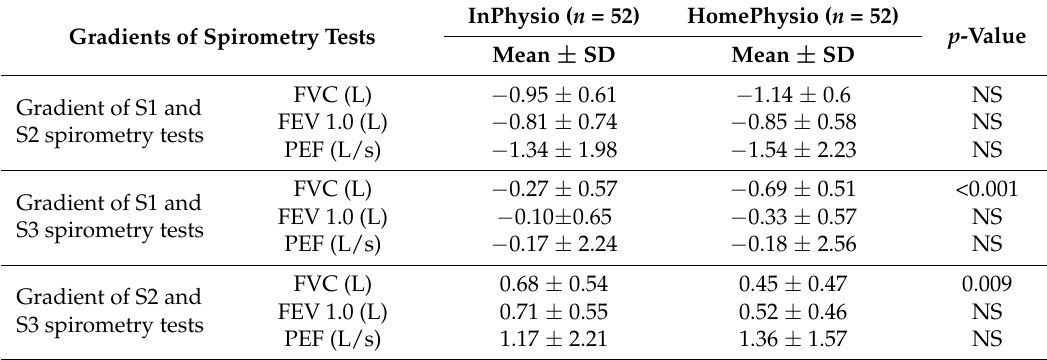
Table 3. The intra-group assessment. Evaluation of average gradients of spirometry test results using means and standard